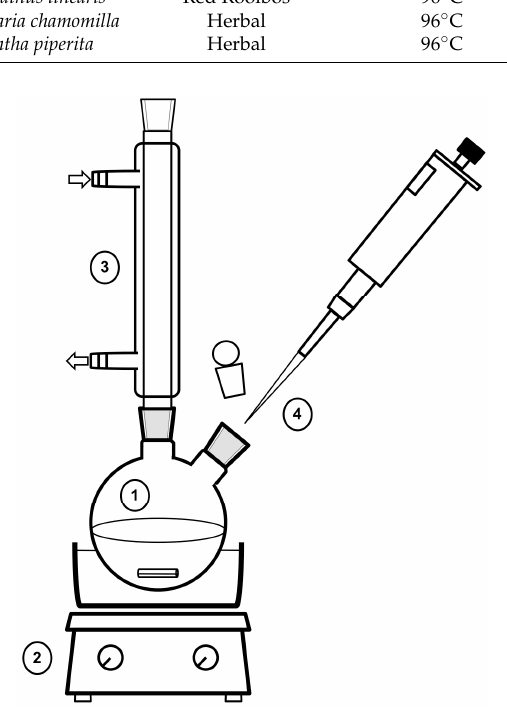
Table 1. Origin and description of teabag